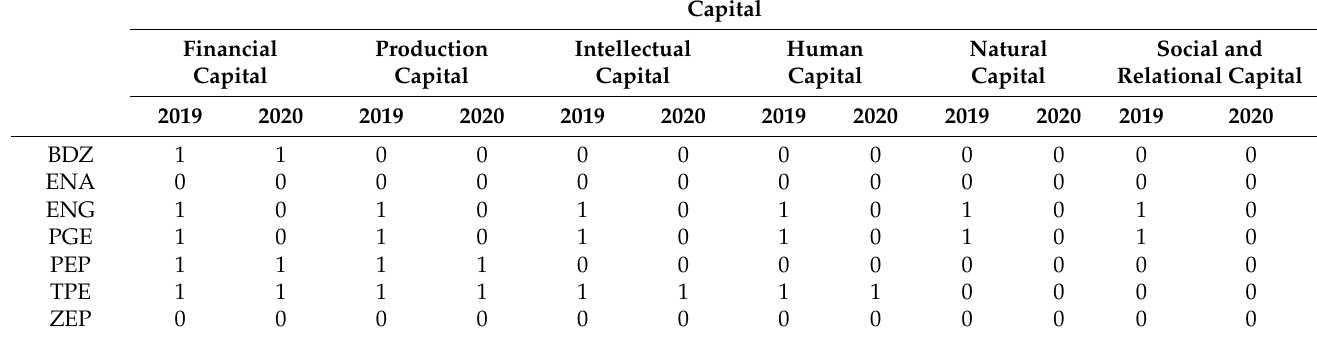
Source: Study based on our own research. Table 6. Business